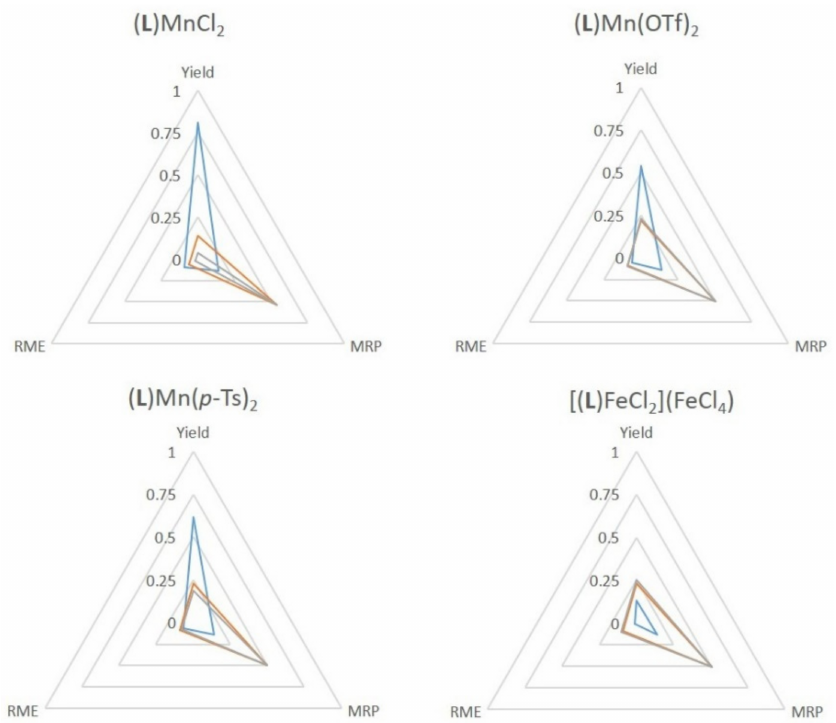
Figure 19. Comparison of green metrics for the epoxidation of cyclooctene (yield, RME and MRP) with the different catalysts and the different co-reagents acetic acid (blue), SiO 2 @COOH (E) (orange) and SiO 2 @COOH (M)